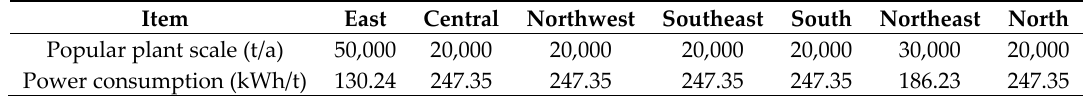
Table 8. Regional energy consumption